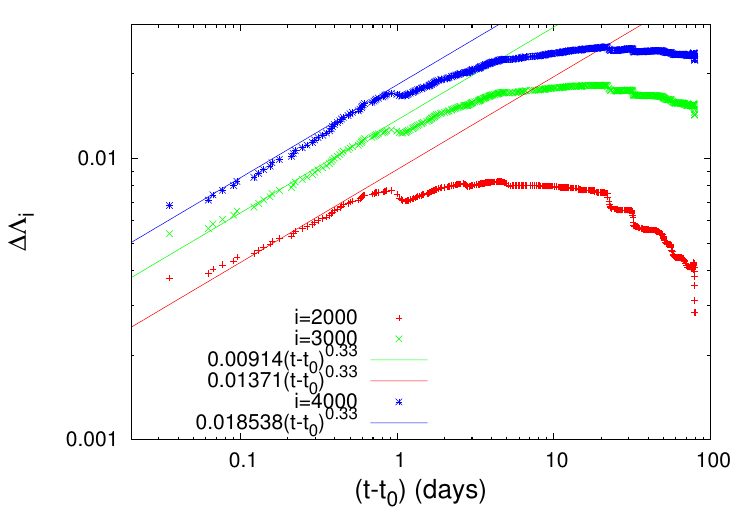
Figure 16. Log–log plot of the change ∆Λ i of the complexity measures Λ 2000 (red), Λ 3000 (green) and Λ 4000 (blue) versus the elapsed time ( t − t 0 ) in days since the establishment of scaling behavior after the occurrence of the M 7.8 EQ on 22 December 2010. The t 0 value is approximately 0.2 days measured from the M 7.8 EQ occurrence and c = 1/3. Taken from Ref.